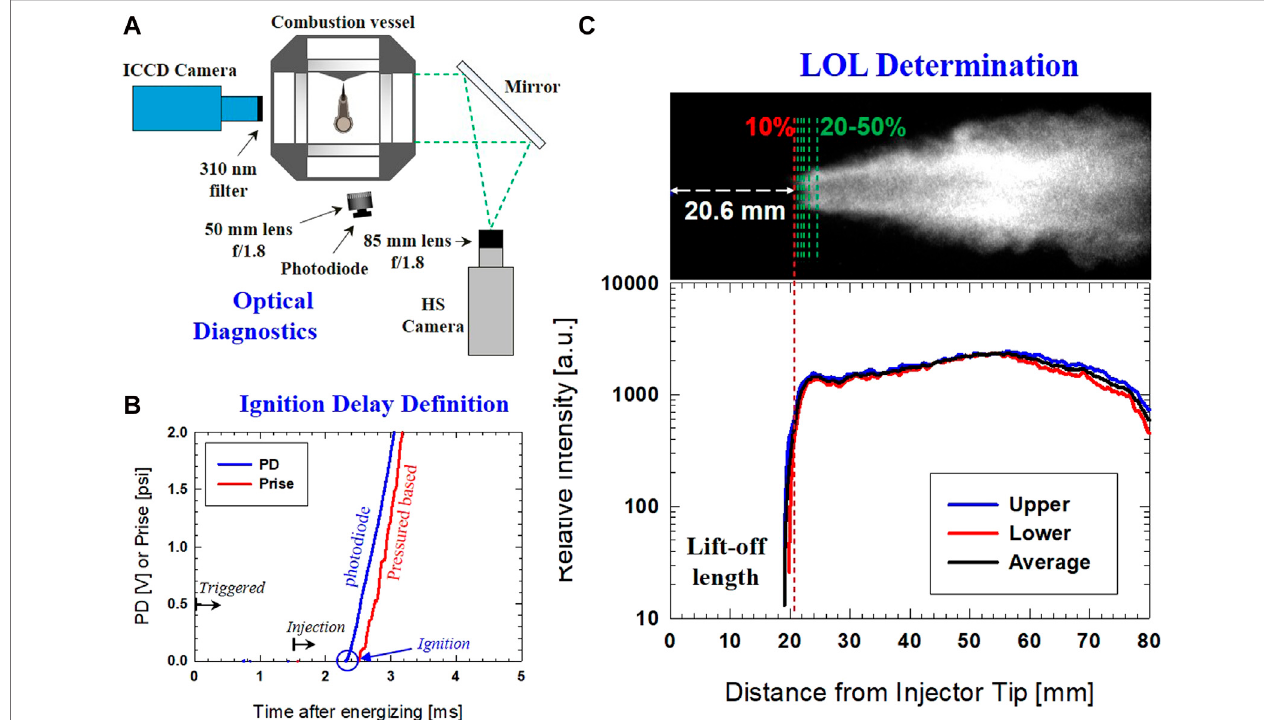
FIGURE 2 | (A) Optical setup for OH* chemiluminescence imaging, photodiode signal, and HS natural luminosity; (B) Ignition delay determination by pressure rise and photodiode signal; (C) Lift-off length determination from OH* chemiluminescence imaging.